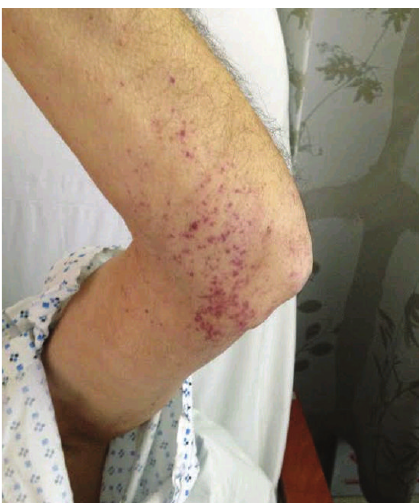
Figure 1: Petechial rash.